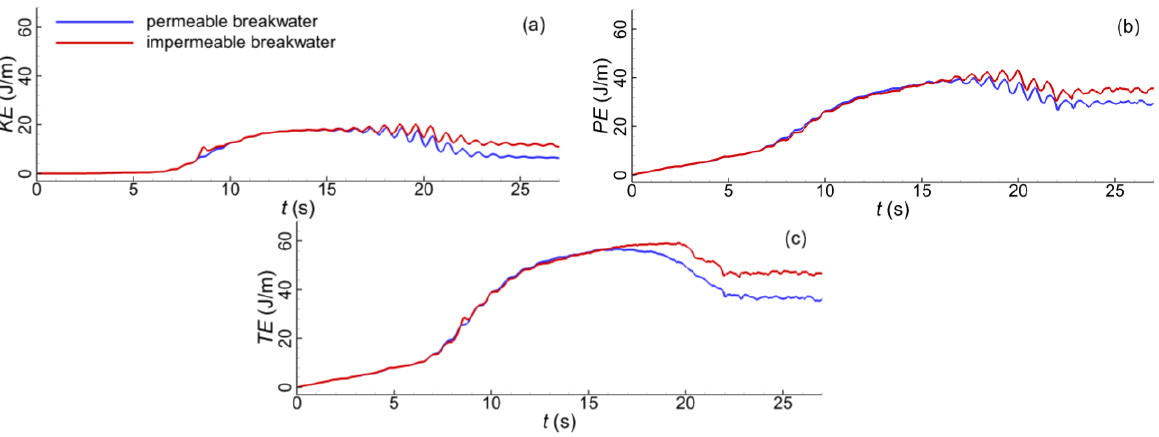
Figure 12. Temporal evolutions of the incident wave energies: ( a ) 𝐾𝐸 , ( b ) 𝑃𝐸 , and ( c ) 𝑇𝐸 .